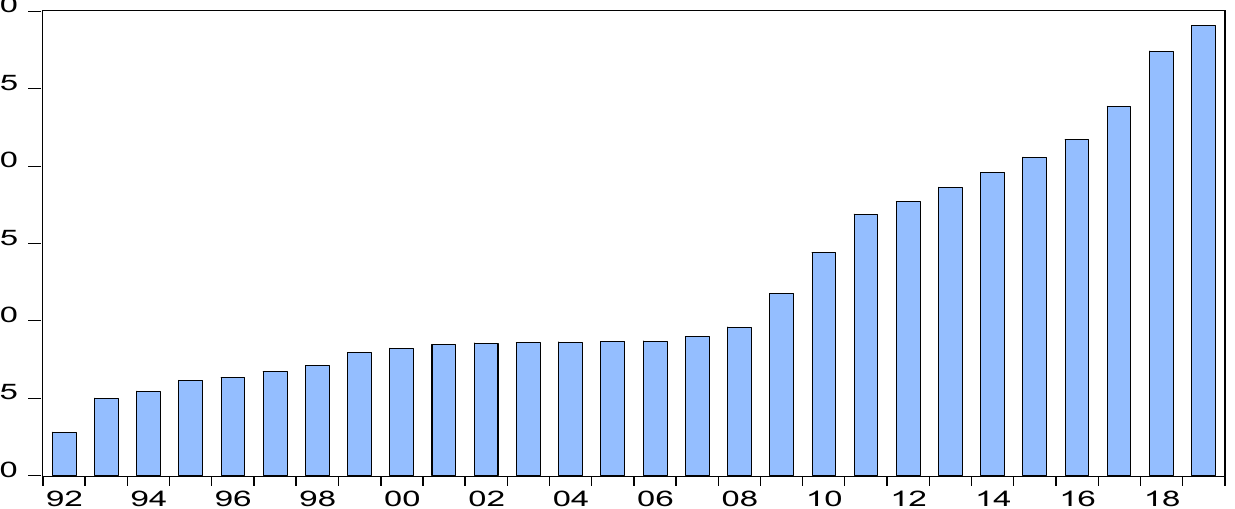
Figure 3. The movement of the exchange rate (ER) in Ethiopia. Source: Constructed by authors using E-view 10.